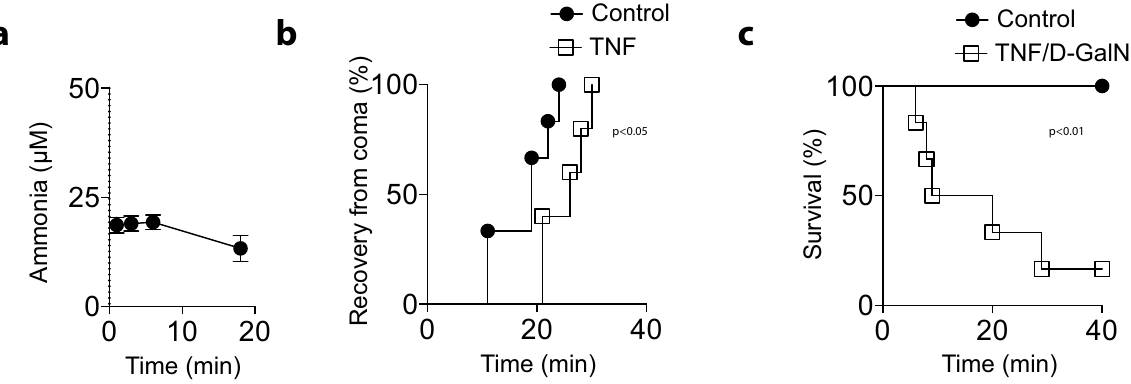
Figure 5. TNF α increases susceptibility towards ammonia toxicity. (a) Ammonia concentrations were measured from retro-orbital venous sinus after i.v. injection of 200 ng TNF (n = 3). (b) C57Bl/6 animals were challenged intravenously with either 200 ng TNF or vehicle. After 3 hours 12 mmol/kg ammonium acetate in PBS was injected intraperitoneally followed by measurement of the coma time (n = 5–6). (c) C57Bl/6 mice were injected with D-Gal and after 15 minutes with 200 ng TNF. After 3 hours animals were challenged with 12 mmol/ kg ammonium acetate in PBS along with a control group (n =